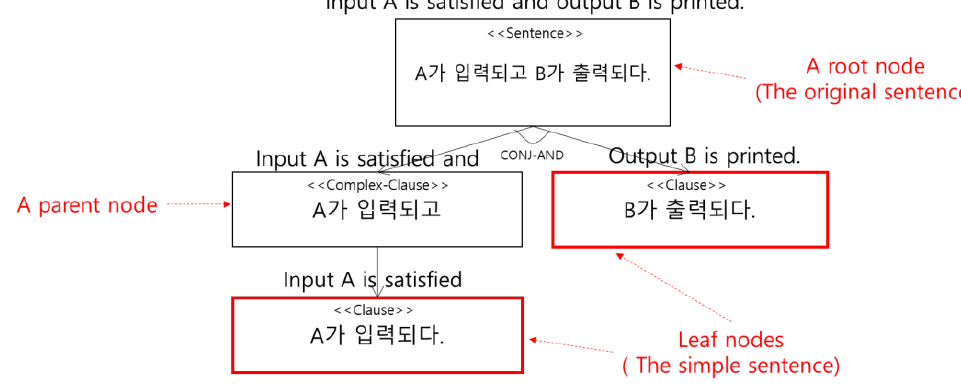
Figure 5. AND conjunction relationship.